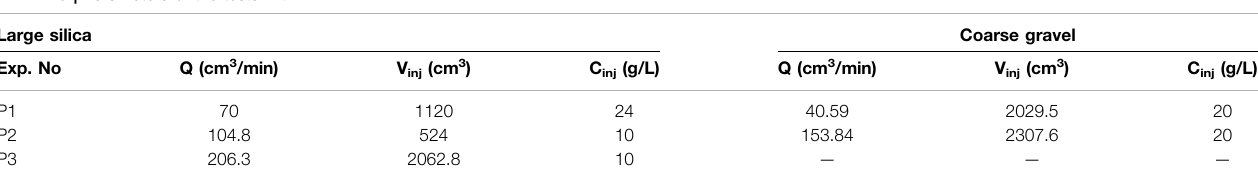
TABLE 5 | Parameters of the tests with